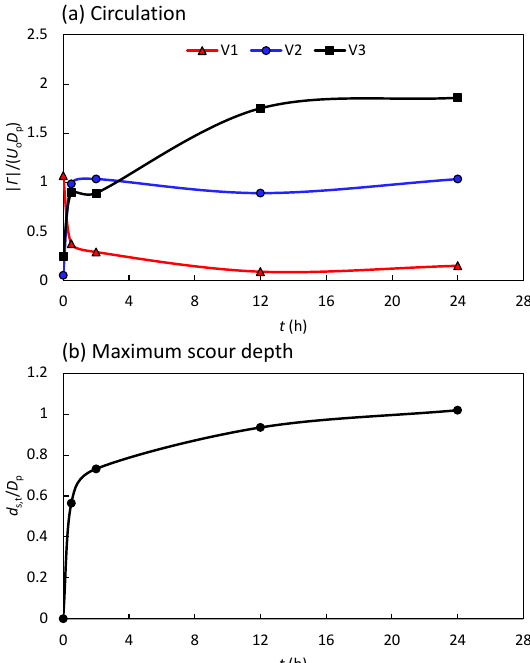
Figure 6. Temporal development of ( a ) vortex circulation of V1, V2, and V3; ( b ) maximum scour depth at X w = 2 D p.